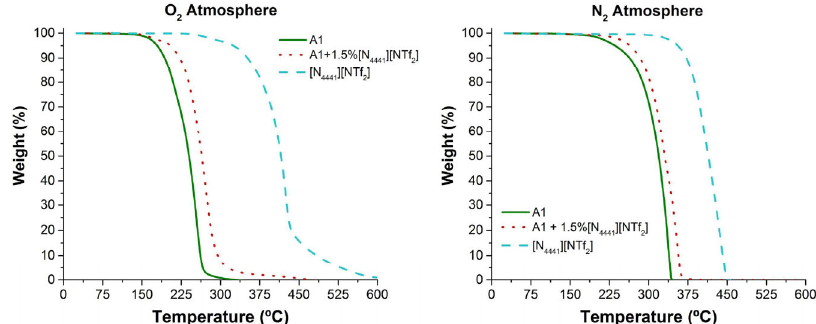
Fig. 2 Thermogravimetric characteristics of the lubricant samples under oxygen and nitrogen atmospheres.